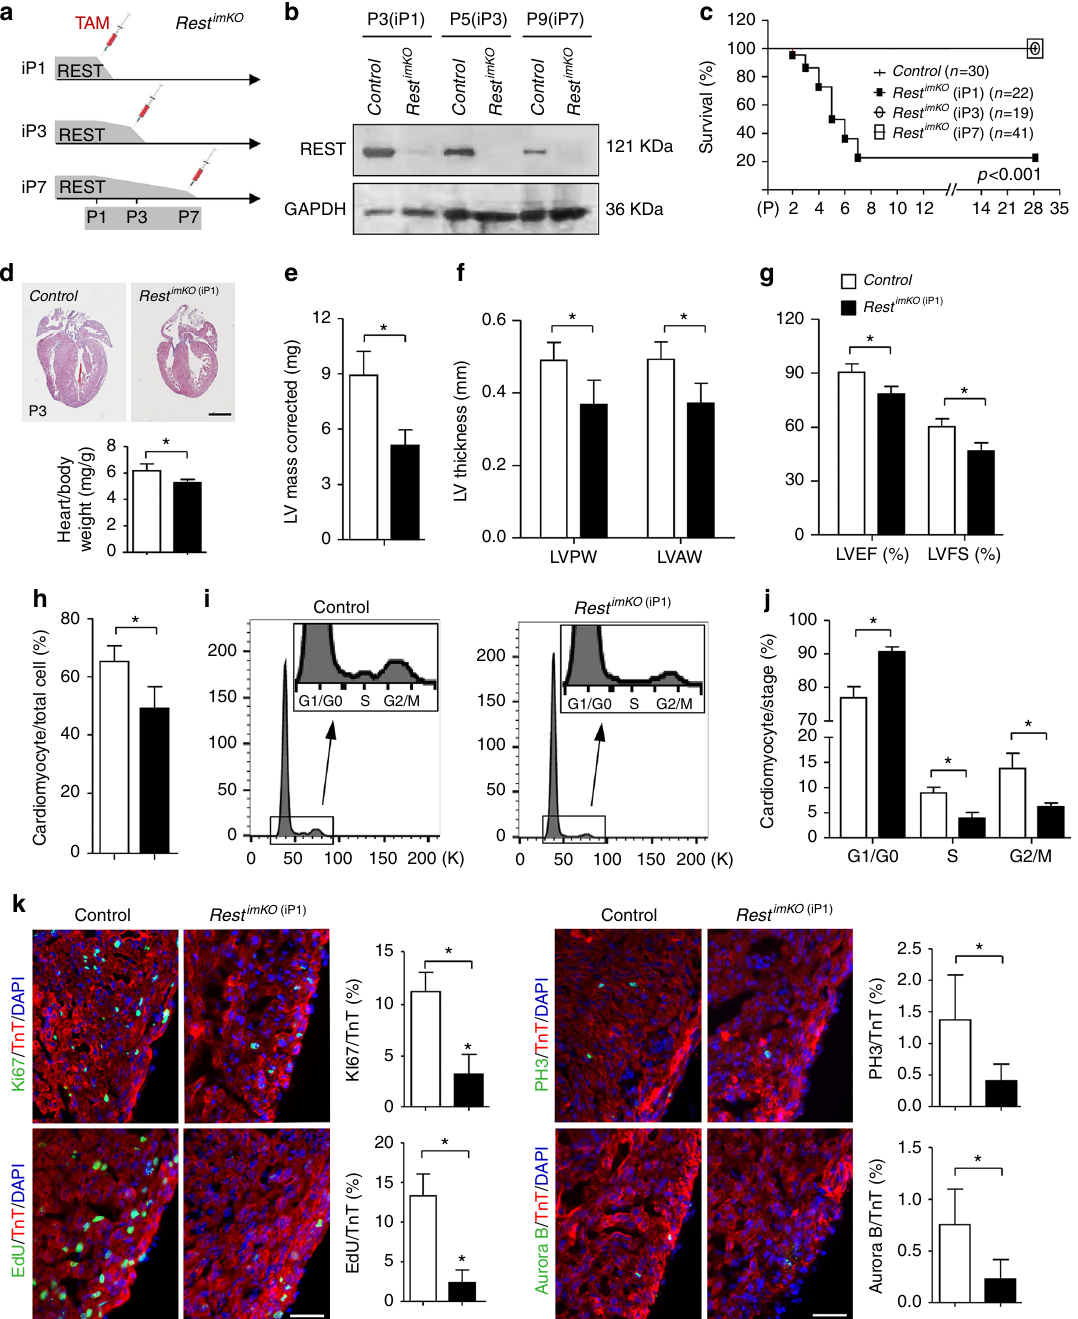
Fig. 2 Rest is required for neonatal cardiomyocyte proliferation and cardiac function. a A graph of experimental design for generating myocardial Rest knockout ( Rest imKO ) at different postnatal (P) stages using the inducible TnT MerCreMer deleter mice. b Western blots showing effective deletion of Rest . c Survival curve of control and Rest imKO mice, p < 0.001, log-rank (Mantel – Cox) testing between mice with Rest deletion at different stages and control (Tam- treated Rest +/+ ;TnT MerCreMer /+ mice). d Representative H&E staining and heart/body weight ratio revealing underdeveloped Rest imKO hearts at P3 after Rest deletion at P1. n = 5/group. Scale bar = 100 µ m. e – g Echocardiography showing structure defects and decreased left ventricle function of P3 Rest imKO . n = 6 for Rest imKO ; n = 8 for Control. h – j FACS shows reduced percentage of cardiomyocytes isolated from P3 Rest imKO hearts ( h ) and arrested cell cycle of the Rest imKO cardiomyocytes at G0/G1 phase ( i , j ). k Immunostaining for cell cycle markers indicating reduced proliferation of Rest null cardiomyocytes. n = 4/ group for FACS and immunostaining. Scale bar = 40 µ m. Mean ± s.d., * p < 0.05, unpaired two-tailed Student ’ s t